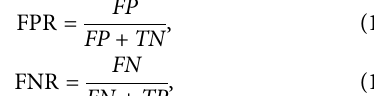
FIGURE 4 | Boxplot of FNR of fault detection regarding the pitch emergency stop (5% labeled samples).